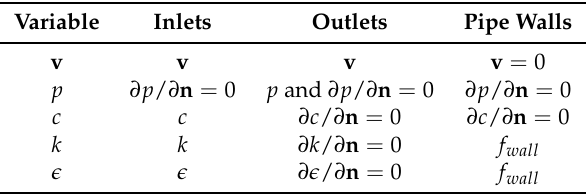
Table 2. Boundary conditions for the passive scalar model.